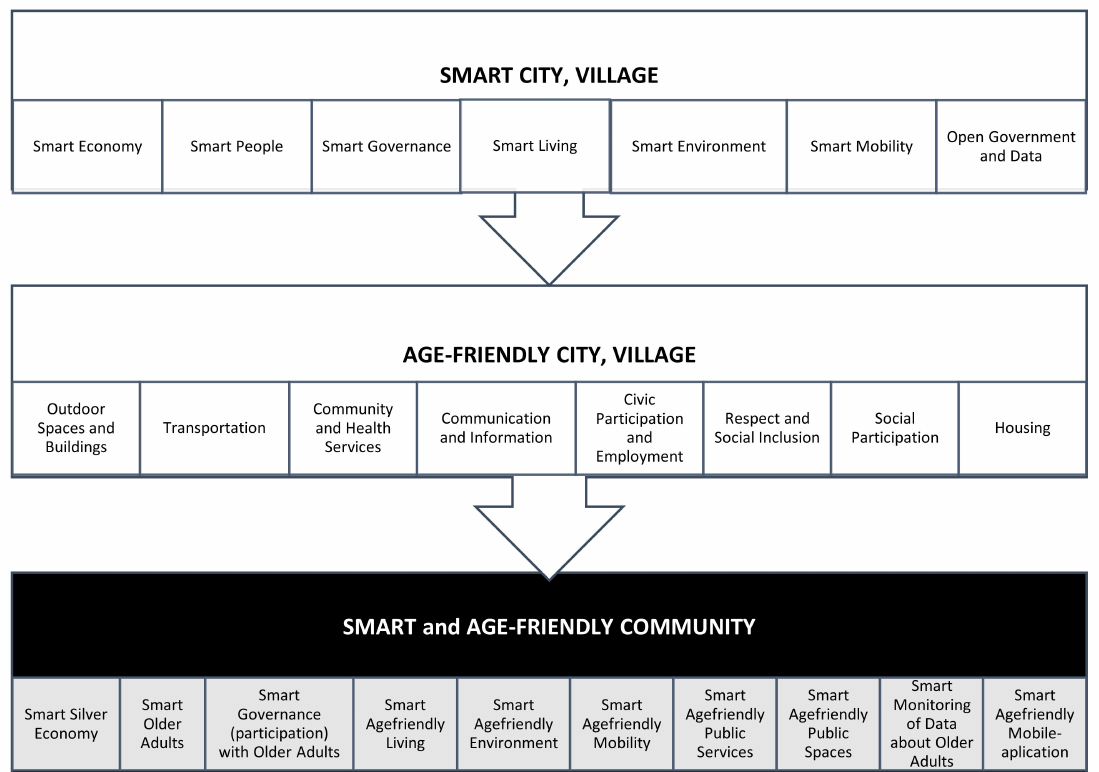
Figure 1. Smart and age-friendly community integrated